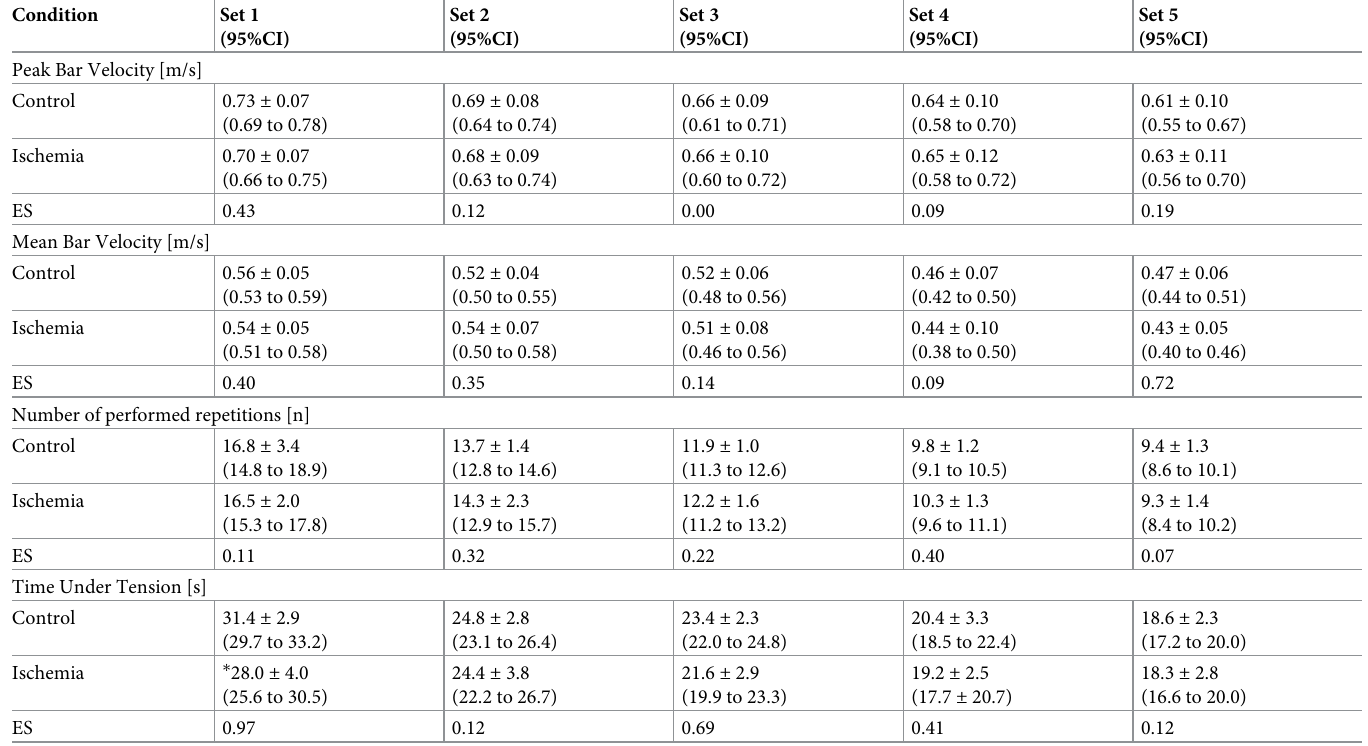
Table 1. Differences in performance variables during control and ischemia